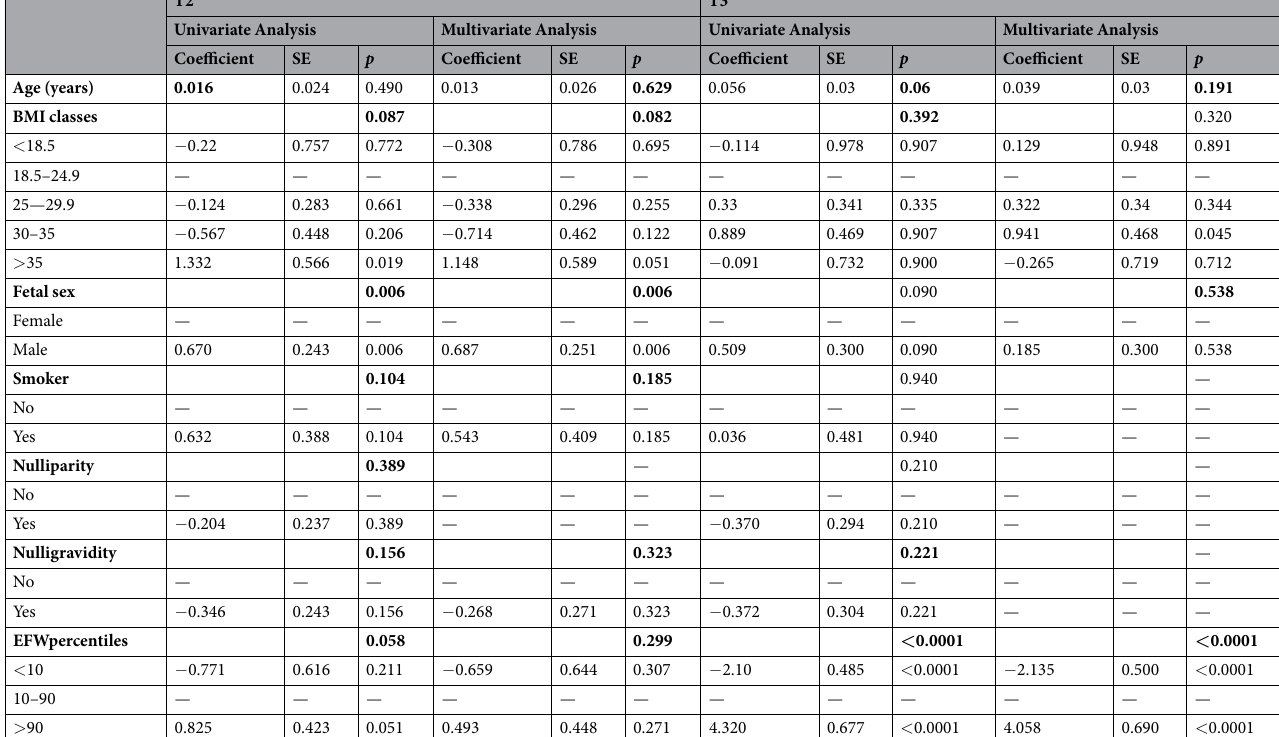
Table 4. Univariate and multivariate linear regression analysis for the amniotic fluid index method (AFI) stratified by